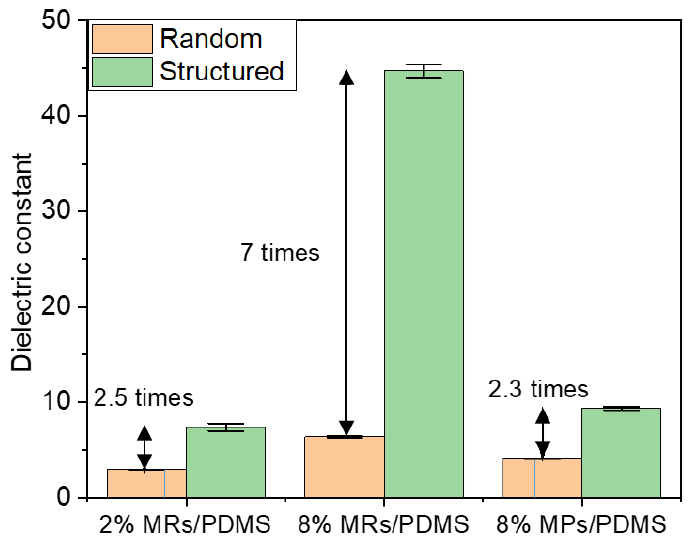
Figure 11. Dielectric constant measured at 1 Hz for different random and structured (i.e., aligned) ZnO MR/PDMS and MP/PDMS composites.